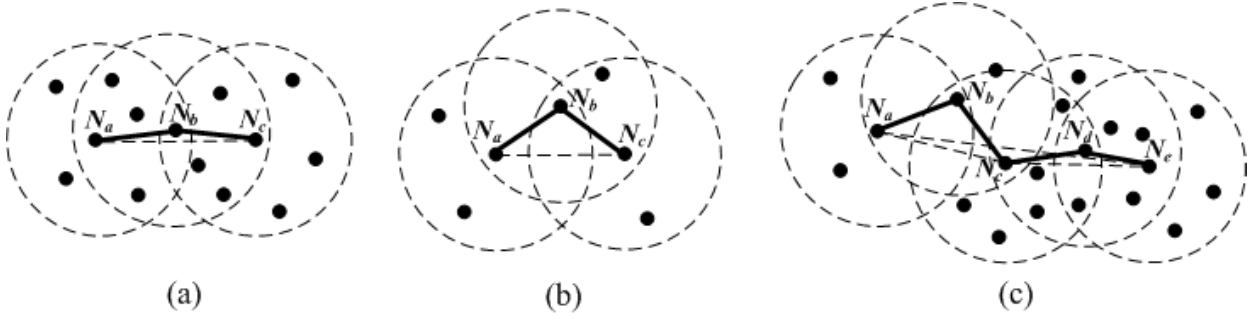
Figure 4. Impact of multi-hop density on multi-hop distance estimation. (a) High density. (b) Low density. (c) High and low